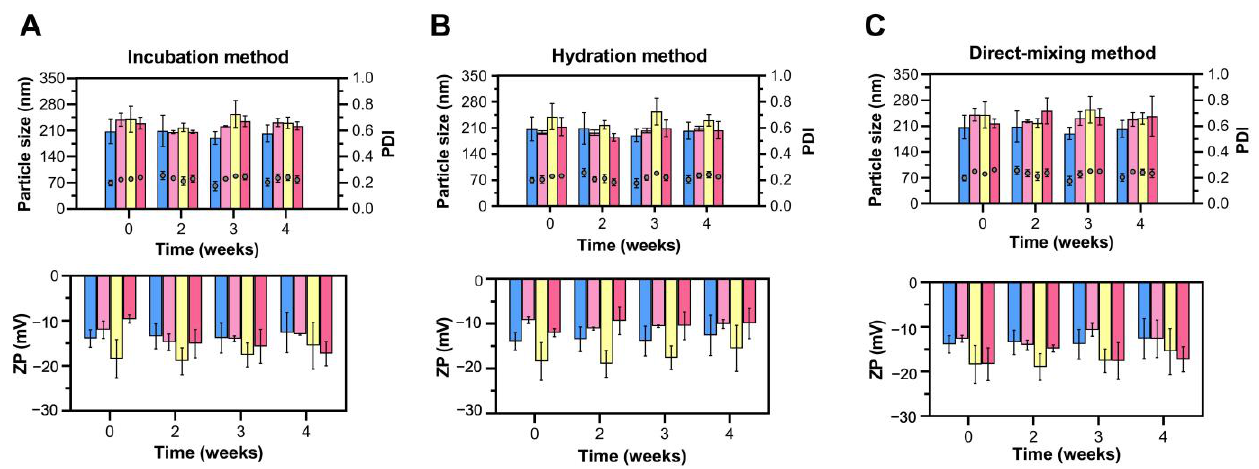
Figure 4. Stability of empty LNLCs and DOX-LNLCs using different loading methods during 4 weeks of storage at 25 ◦ C: ( A ) incubation method, ( B ) hydration method, and ( C ) direct mixing method. Blue data are the empty LNLCS obtained by the lipid film hydration method (M2); yellow data are the empty LNLCS obtained by the emulsification method (M3); and pink data represents the DOX-LNLCs (LNLCs prepared by M2 are lighter pink, while M3 is darker). The data are expressed as mean ± standard deviation of at least three experiments.